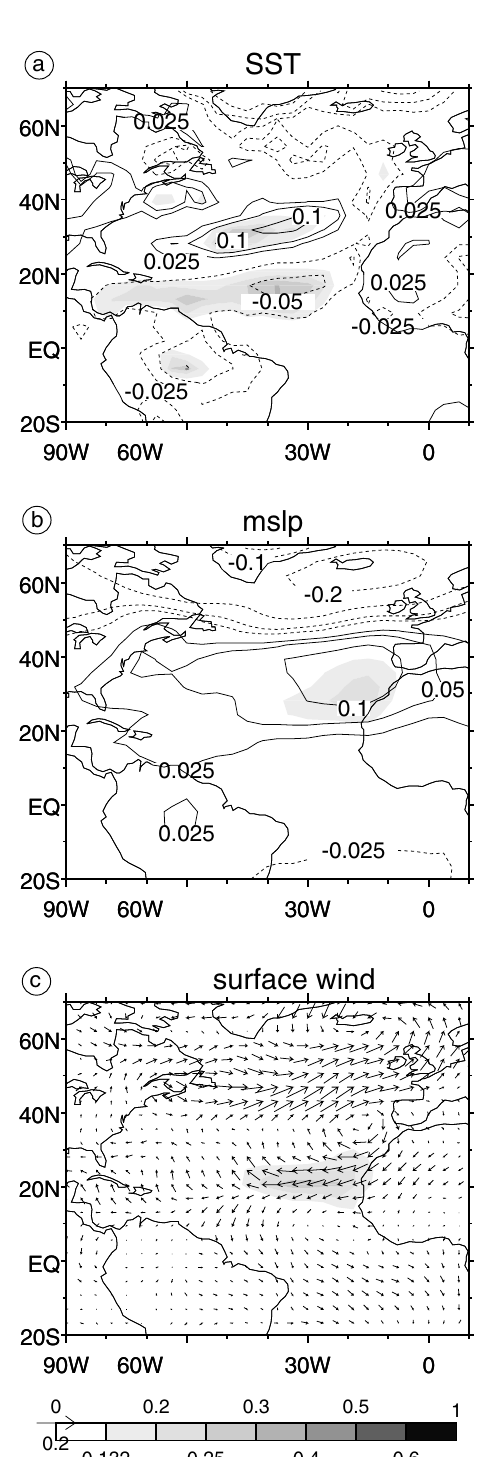
Fig. 7a-c. The regression patterns of low frequency annual sea surface temperature (a), mean sea level pressure (b), and surface wind (c) to the PC1 of the OHT when OHT leading by 2 years for the ECHAM4T30/OPA simulation. Units are in o C, hPa, and m s –1 per unit PC1 of the OHT. Shading scale indicates ex-plained local